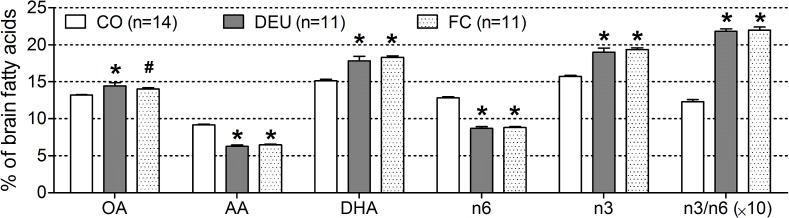
Brain fatty acids in 12-month-old AβPP-PS1 and wild-type mice on control and specific multi-nutrient diets.The relative concentrations of different fatty acids were determined in the lipid fraction of brain homogenates, and were similar between AβPP-PS1 and wild-type mice. Dietary intake affected the relative concentrations of different fatty acids similarly in AβPP-PS1 and wild-type mice. Both the DHA, EPA and UMP (DEU) diet and the Fortasyn® Connect (FC) diet increased the relative concentrations of omega-3 fatty acids (n3) and decreased the relative concentrations of omega-6 fatty acids (n6), resulting in a pronounced shift in n3/n6 ratio in favor of the n3 fatty acids as compared to the control(CO) diet, *p<0.001. The reduction of the relative n6 content was mainly caused by a decrease in arachidonic acid (AA; C20∶4n6), while the higher n3 content was mainly caused by an increase in docosahexaenoic acid (DHA; C22∶6n3), *p<0.001. The relative concentration of oleic acid (OA; C18∶1n9) was increased due to intake of the DEU diet *p = 0.005), while it was only slightly, but not significantly, increased due to intake of the FC diet (#
p = 0.066). The relative amount of palmitic acid (C16∶0); stearic acid (C18∶0), saturated fatty acids, mono-unsaturated fatty acids and poly-unsaturated fatty acids were unaffected by dietary intake (data not shown).